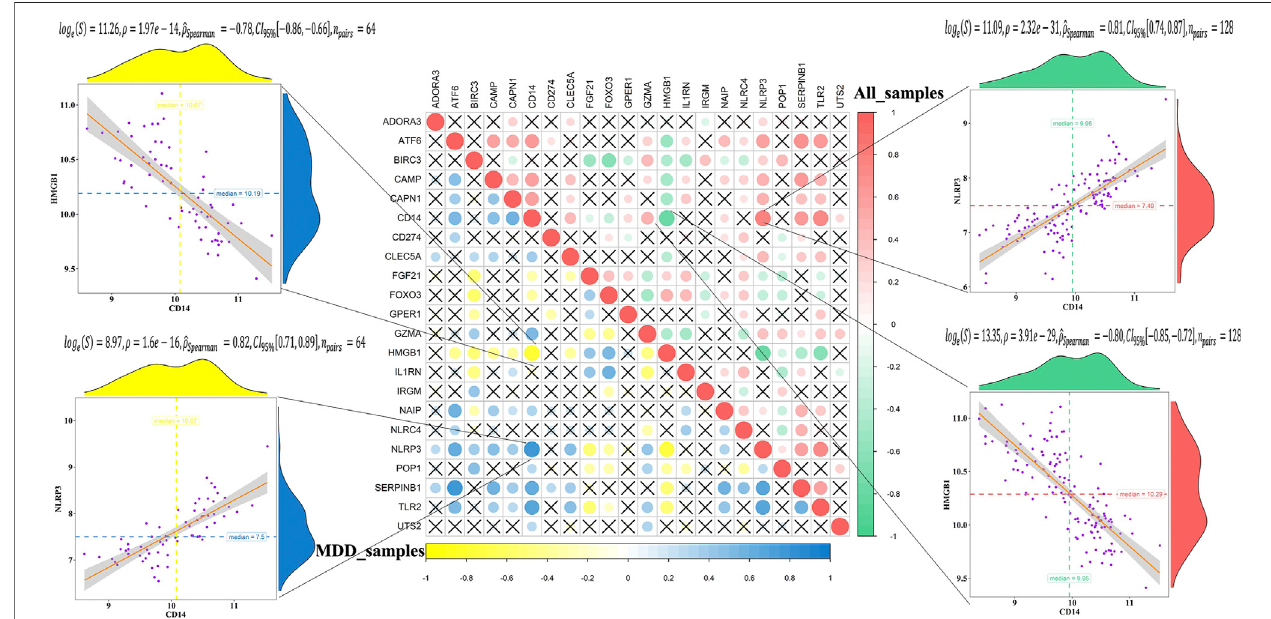
FIGURE 2 | Correlation analysis of 23 differentially expressed pyroptosis-related genes in all samples and MDD